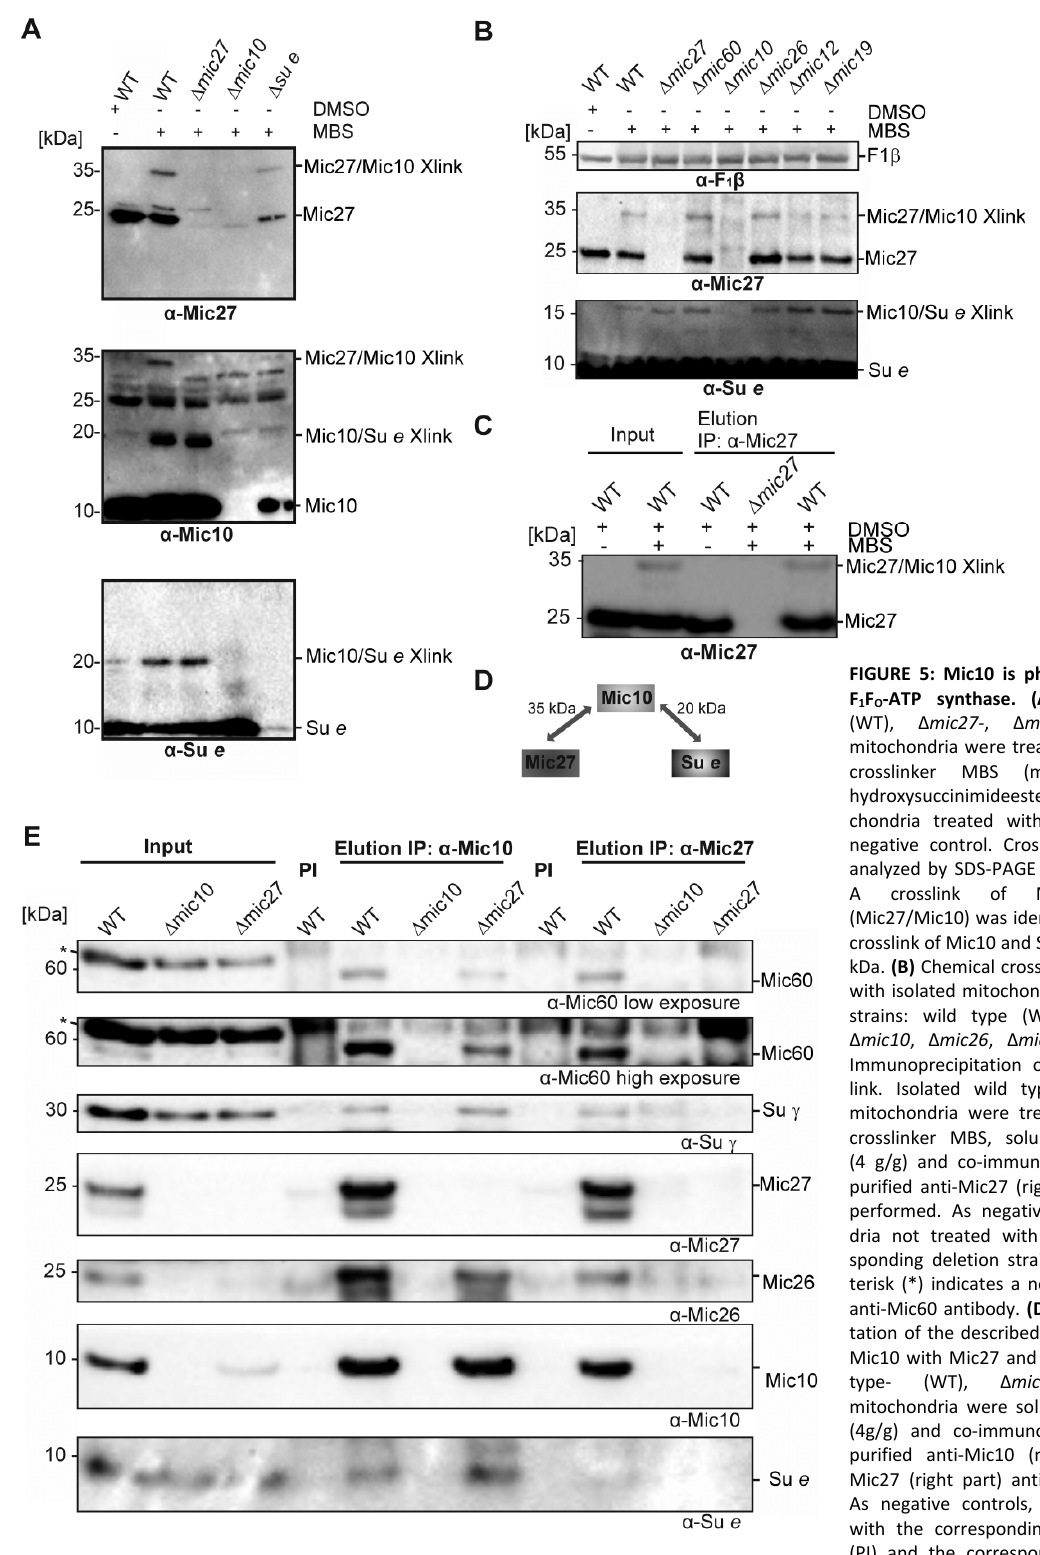
267 Microbial Cell | AUGUST 2017 | Vol. 4 No. 8